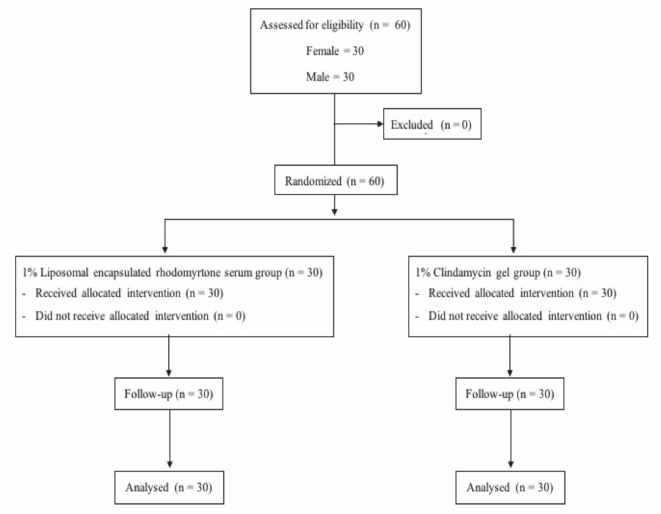
Figure 1. Clinical study